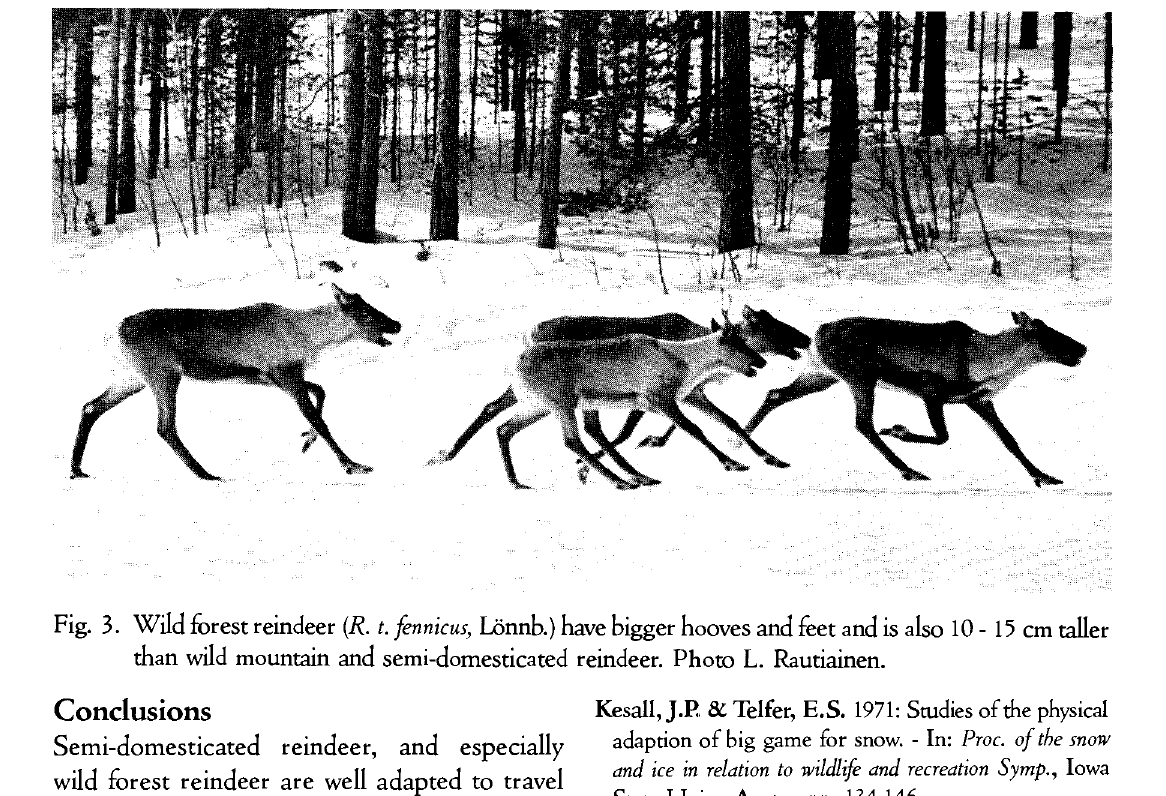
Fig. 3. Wild forest reindeer (R. t. fennkus, Lönnb.) have bigger hooves and feet and is also 10 - 15 cm taller than wild mountain and semi-domesticated reindeer. Photo L.